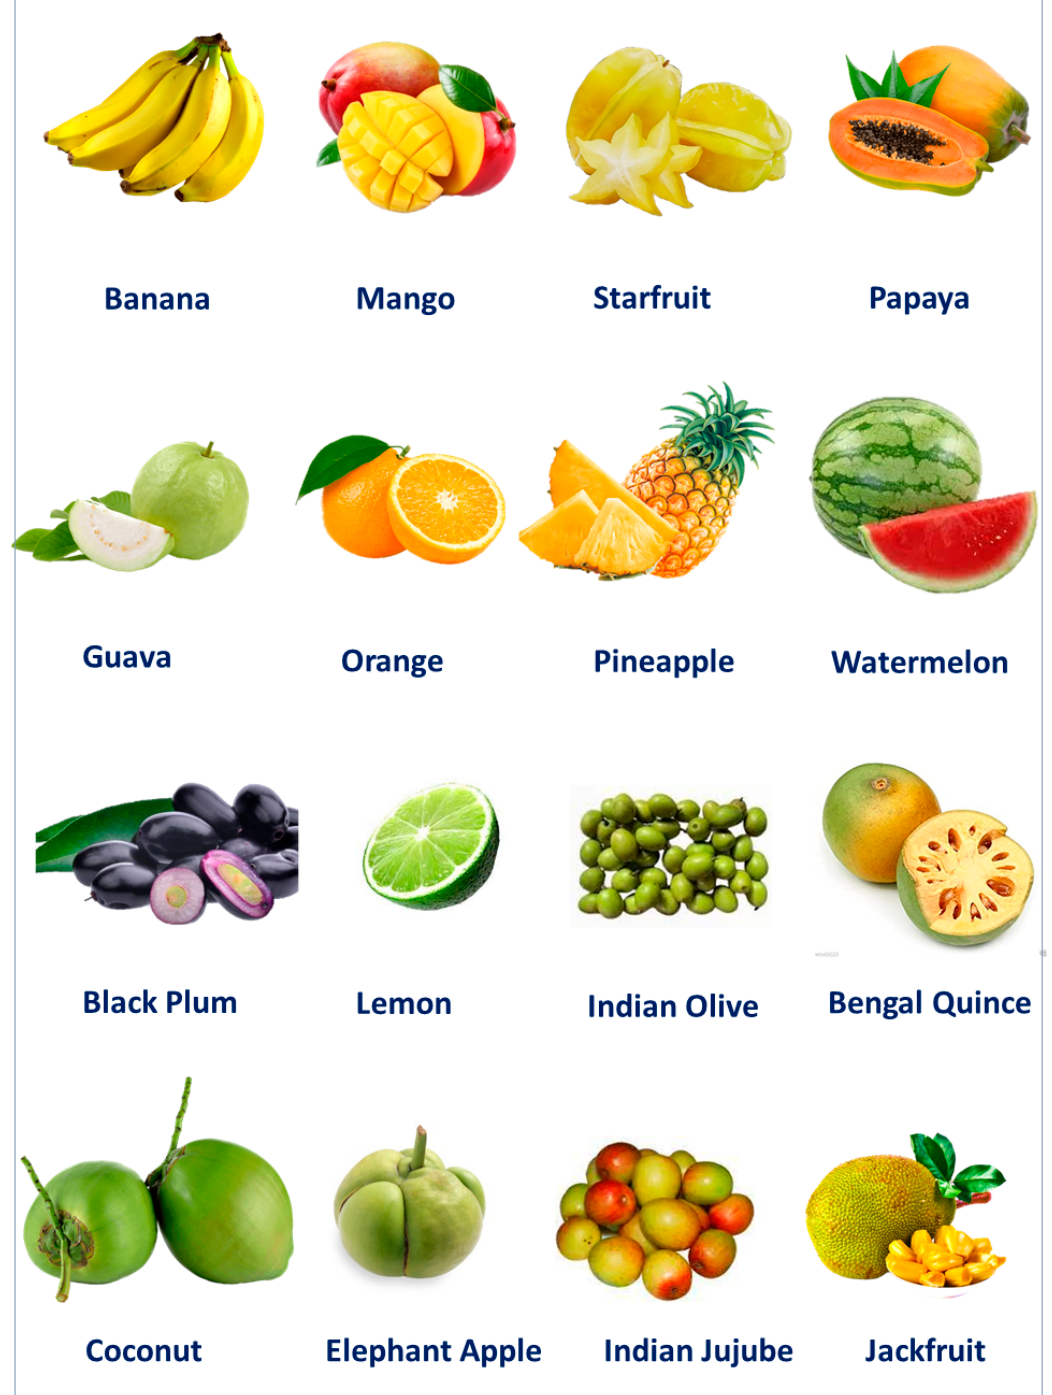
Figure 3. Few commonly available fruits in